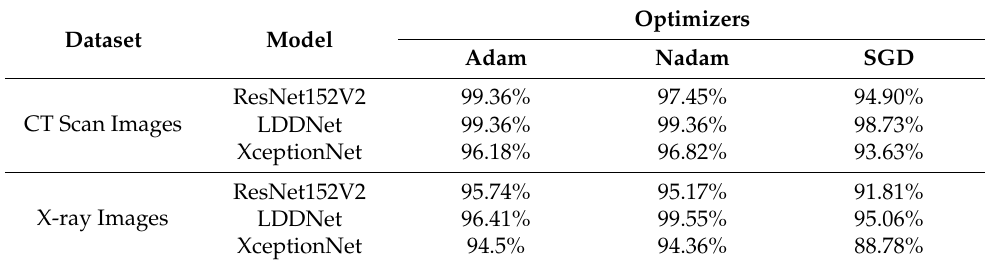
optimizer. Table 11. Overall performance of the experimental models applied to different